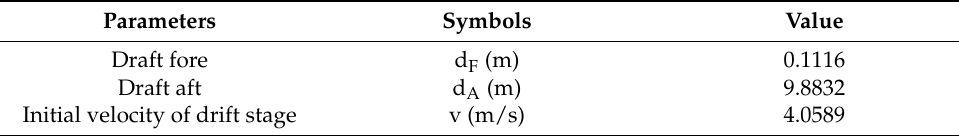
Table 1. Calculation results of the ship’s longitudinal